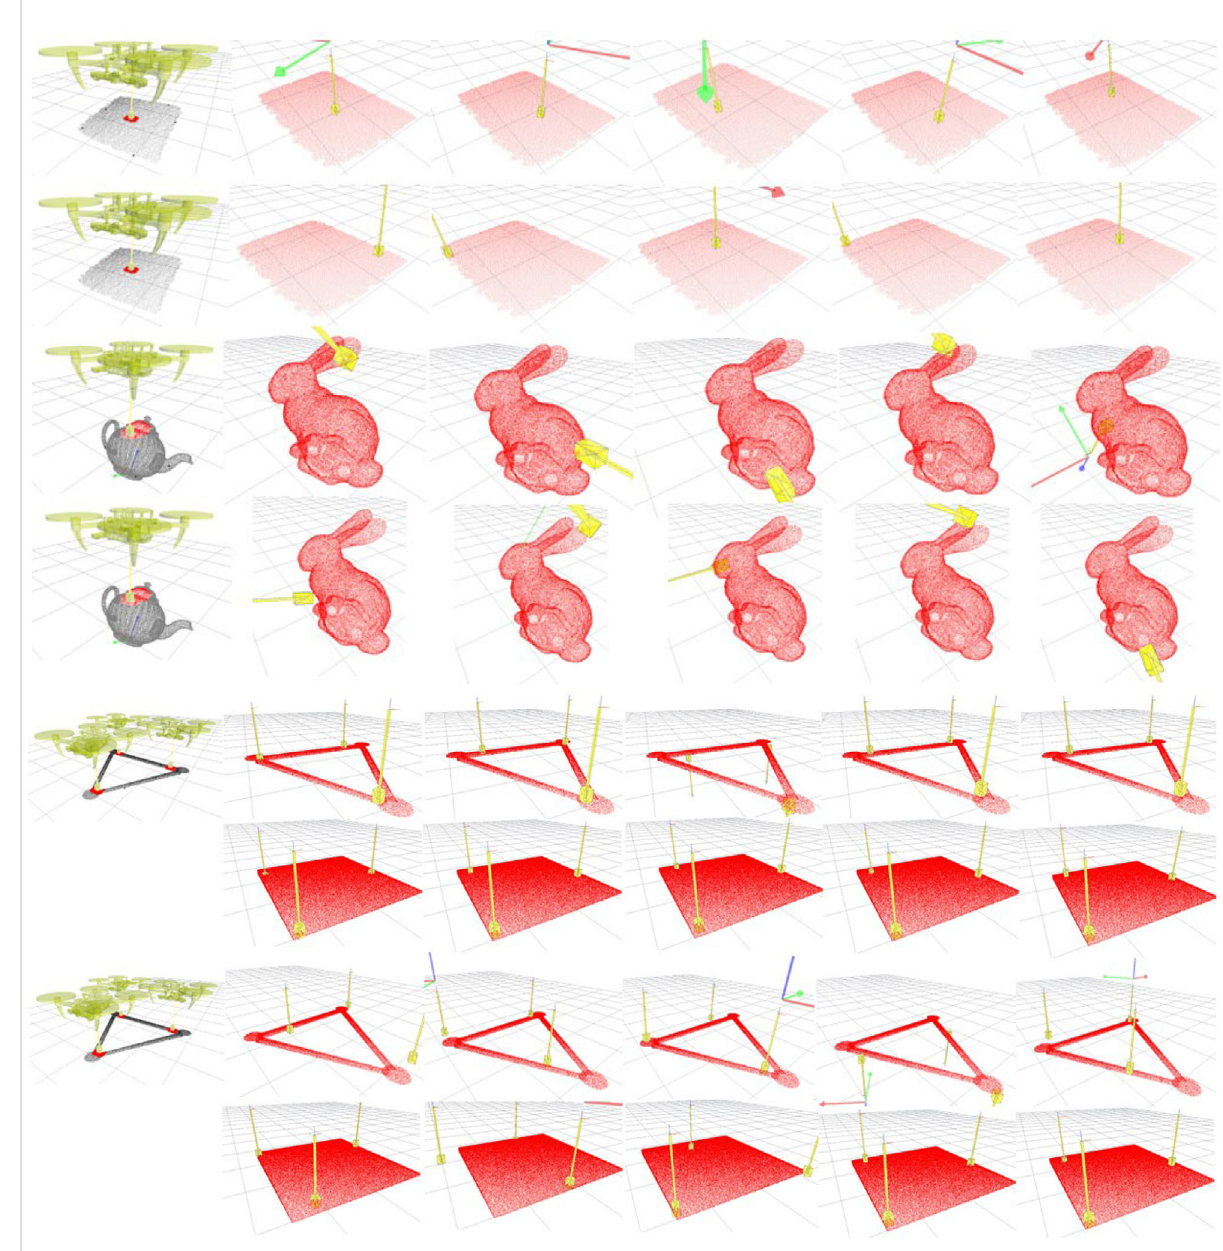
2016).The fi rstcolumnshowstheUAVs con fi guration, thesurfaceused forlearning andthecontact features. Red pointsare thelocal featuresofthe contacts; black points are the task features. The other columns demonstrate the link pose computed on a new surface. The associated drone ’ s pose is shown with a frame using the conventional RGB colour map for x-, y-, and z-axes,